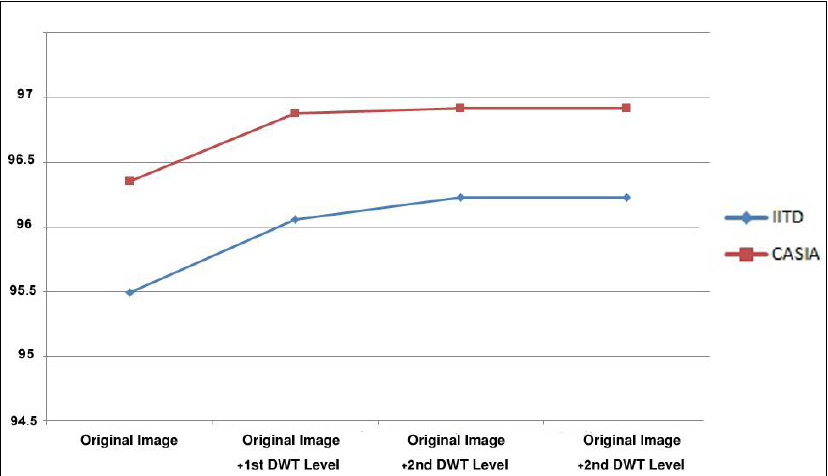
Figure 7. Recognition rates using several DWT decompositions applied to the CASIA and IITD databases.